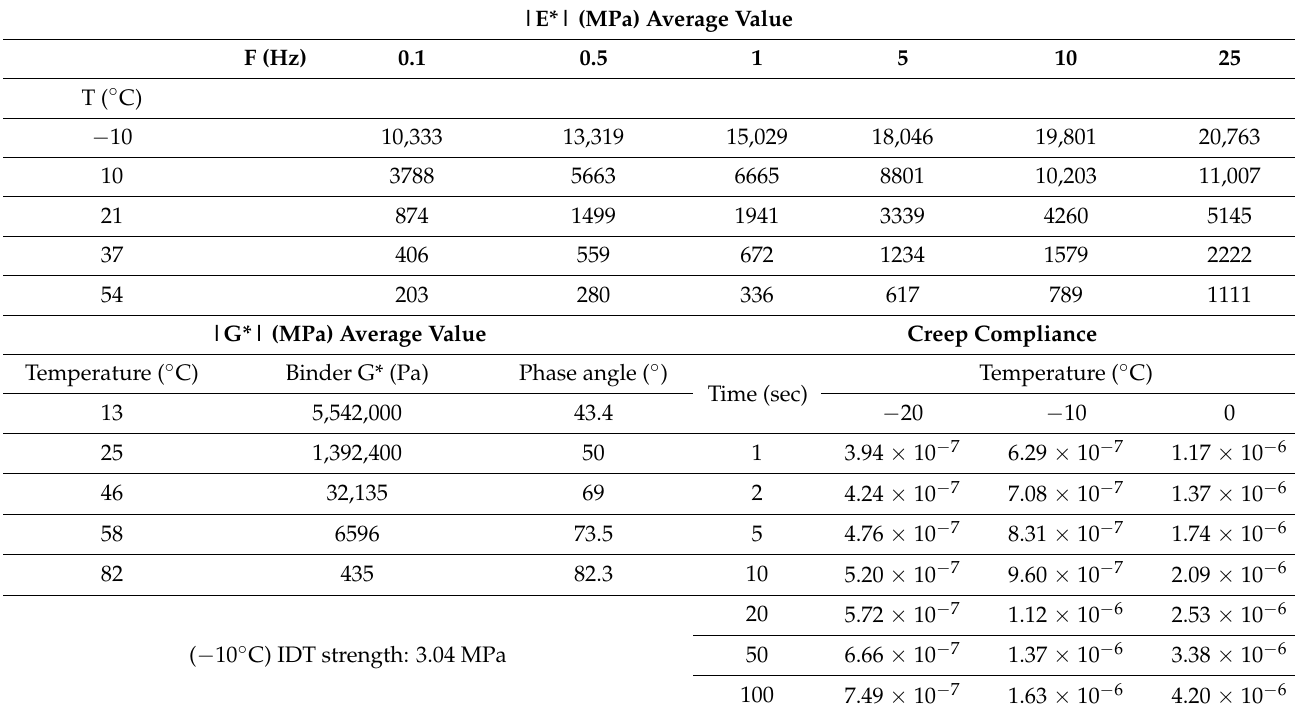
Table 5. Pavement M-E input for 19 mm- HMA.